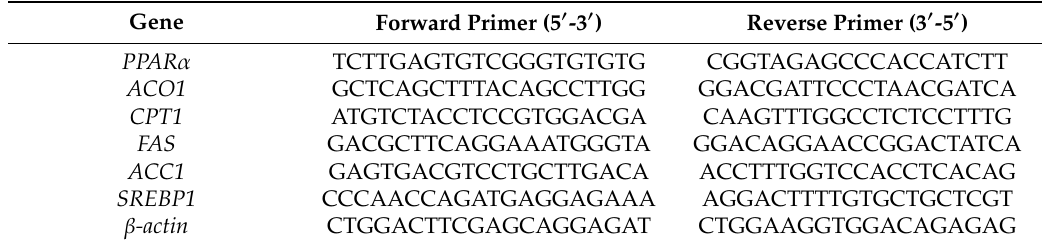
Table 4. List of complementary DNA (cDNA) of the amplified genes and primers used.